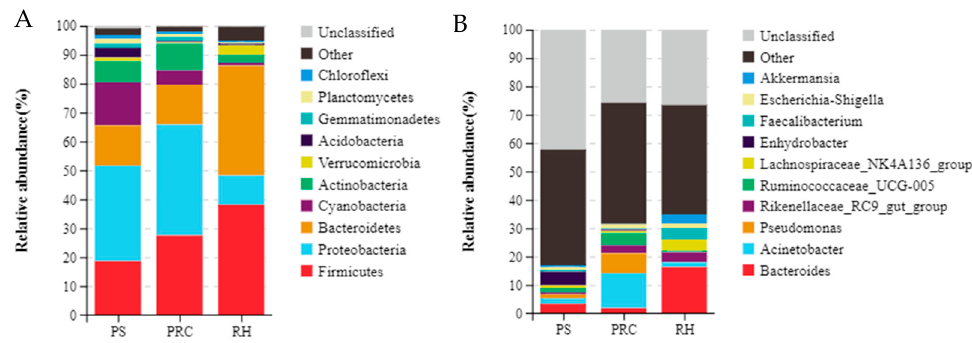
Figure 4. Bacterial composition in colostrum at the phylum ( A ) and genus ( B ) level for dairy cows from different bedding materials. PS = peanut shells, PRC = peanut–rice combination, RH = rice husks.